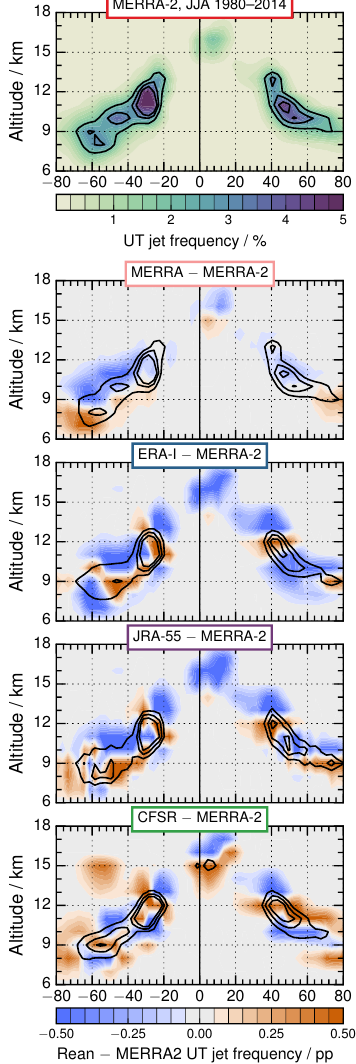
Figure 8. Latitude–altitude cross sections of JJA jet frequency dis- tributions for MERRA-2 (top), and differences between MERRA-2 and MERRA, ERA-I, JRA-55, and CFSR. Overlaid contours are climatological frequency distributions for each reanalysis of 2, 3, and